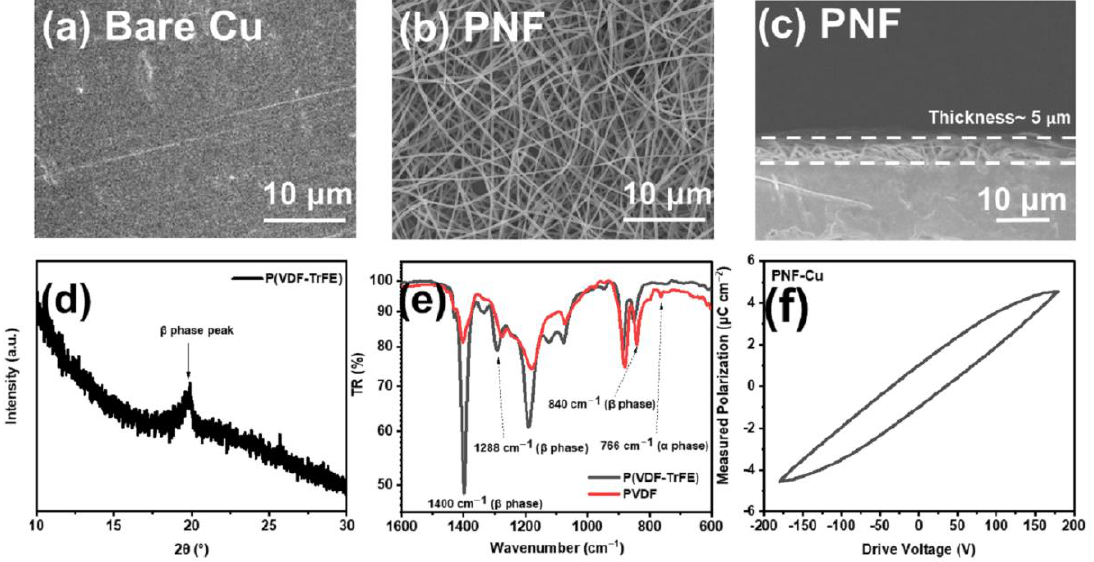
Figure 1. ( a ) Top-view SEM images of bare Cu foil and ( b ) PNF, ( c ) cross-sectional SEM image, ( d ) XRD pattern, ( e ) FTIR spectra, and ( f ) hysteresis loop of PNF.